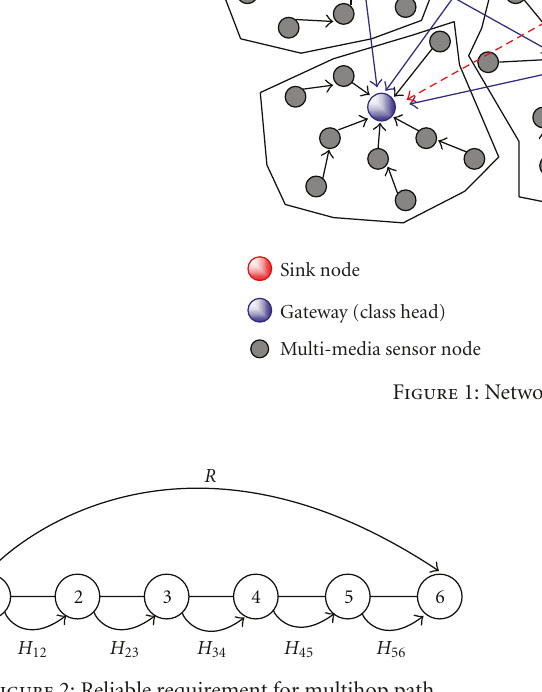
Figure 2: Reliable requirement for multihop